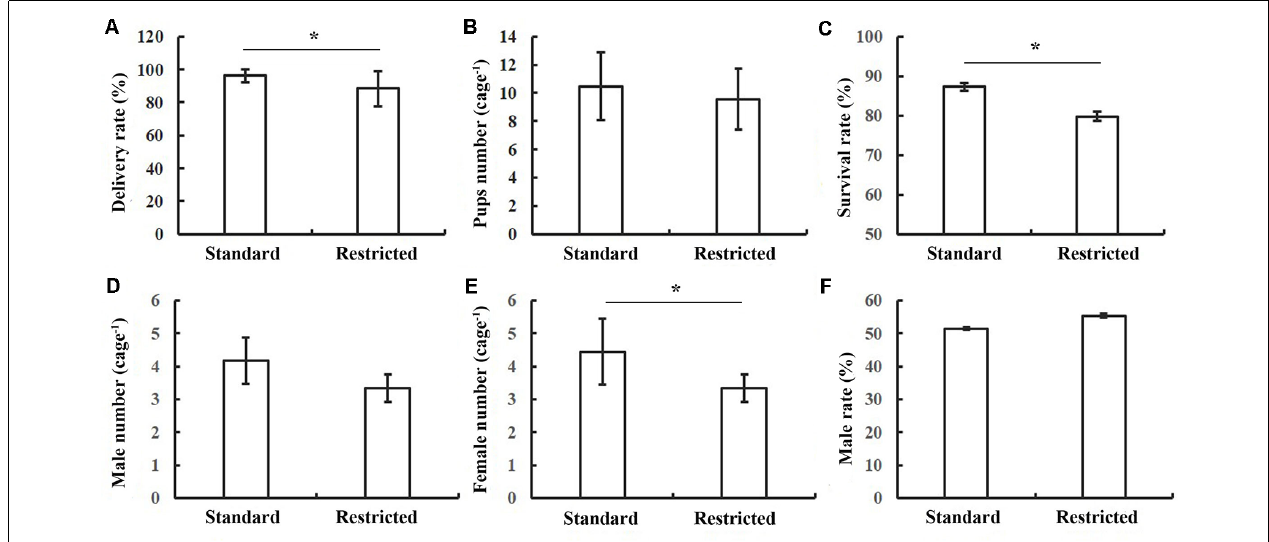
FIGURE 1 | Statistical results of reproductive performance of mice under two conditions. (A) The delivery rate of mice was decreased in the restricted group. (B) No significant difference in pups’ number between two groups. (C) The survival rate of pups was decreased in the restricted group. (D) No significant difference in the survival male number of pups between two groups. (E) The survival female pups in restricted group were decreased. (F) No significant difference in survival male rate between standard and restricted groups. The error bars mean standard deviations. * P < 0.05, n = 26 per group.